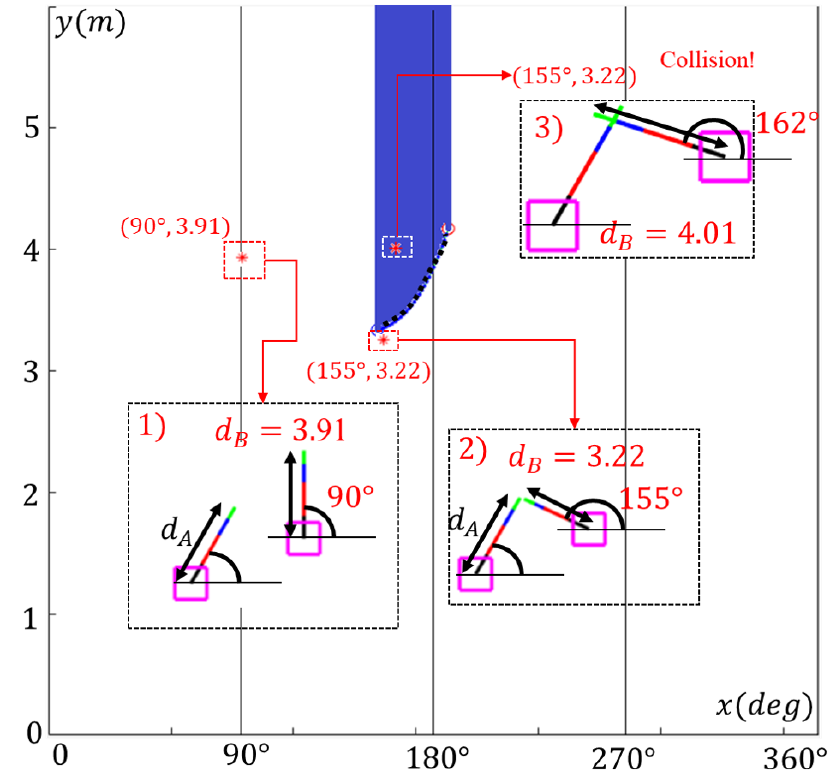
Figure 9. The obstacle image generated in the S 2 with three cases